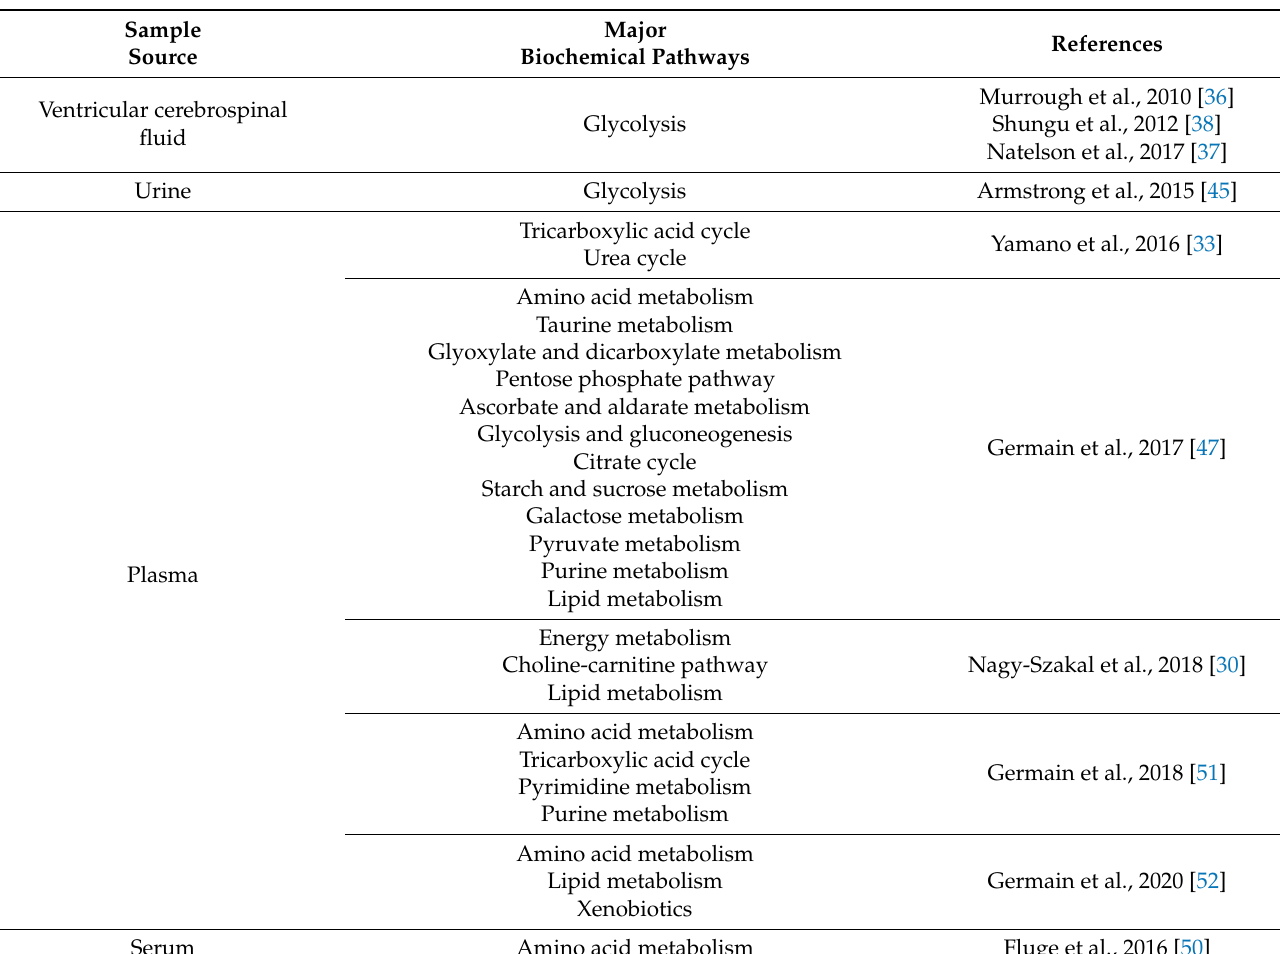
Table 2. Summary of major biochemical pathways with significant metabolites across patients with